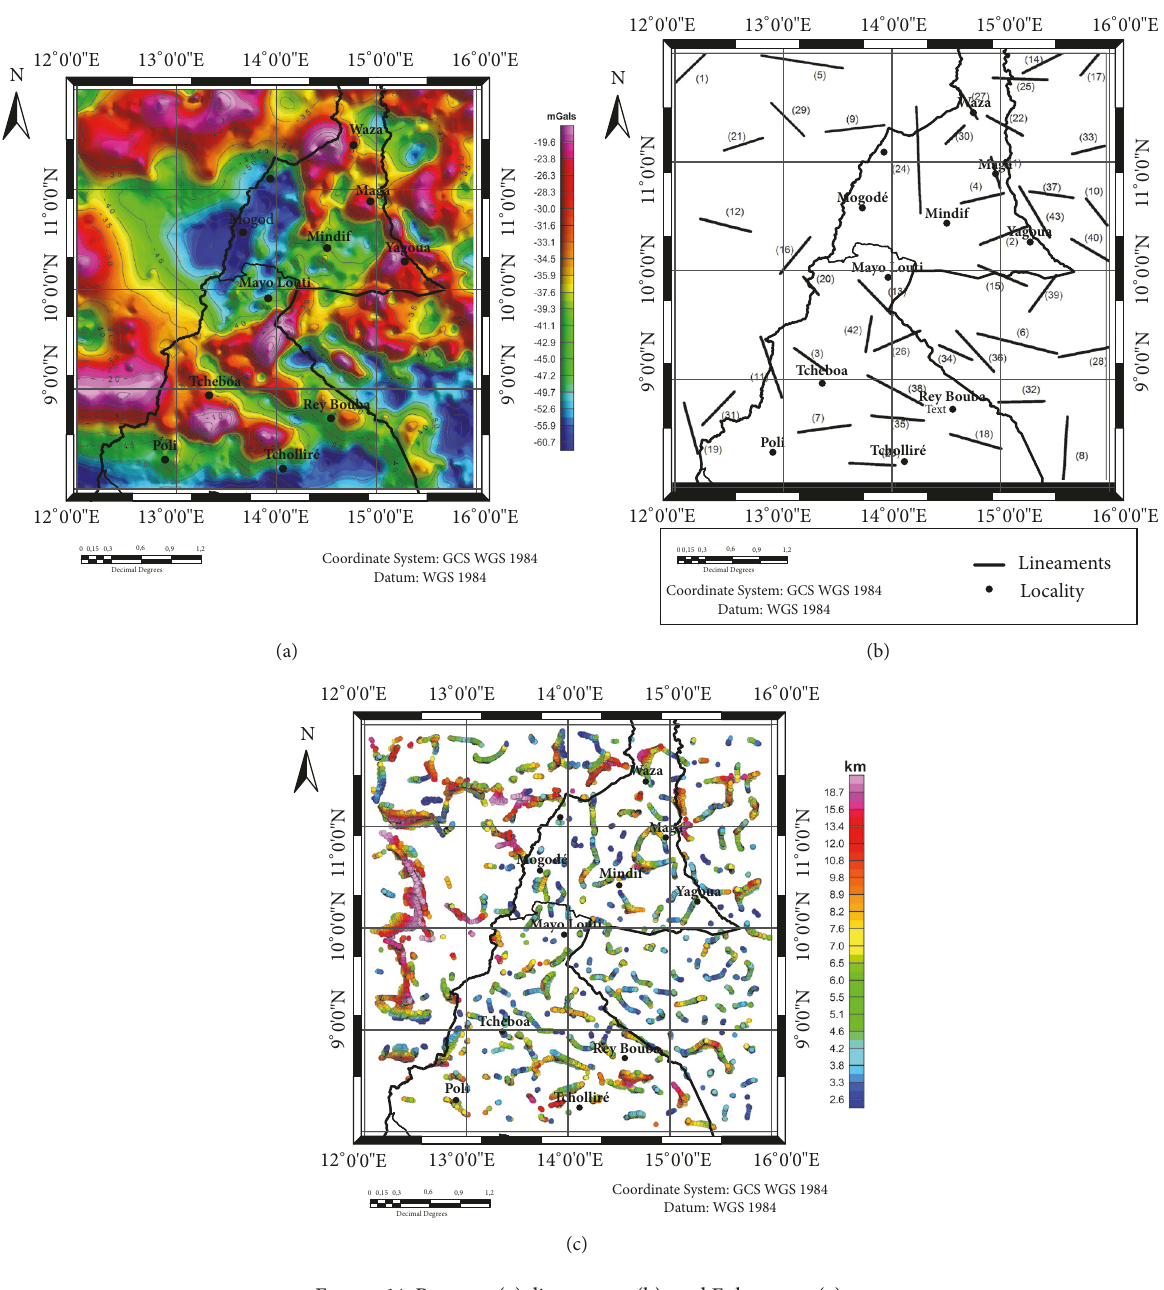
Figure 14: Bouguer (a), lineaments (b), and Euler maps (c).